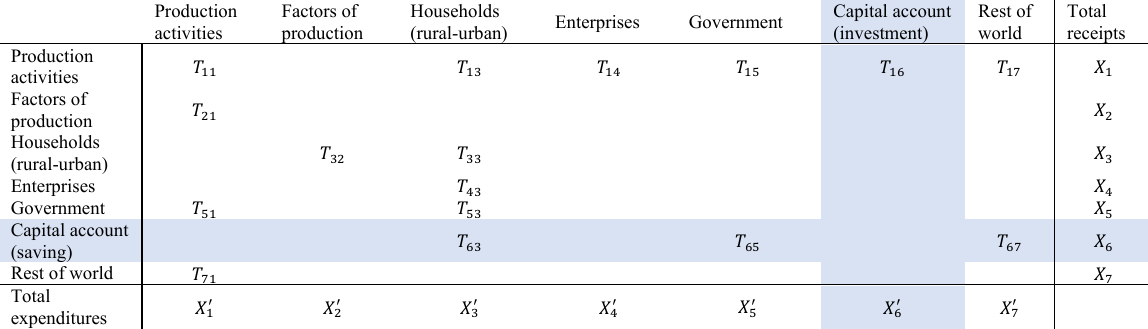
Schematic framework of social accounting